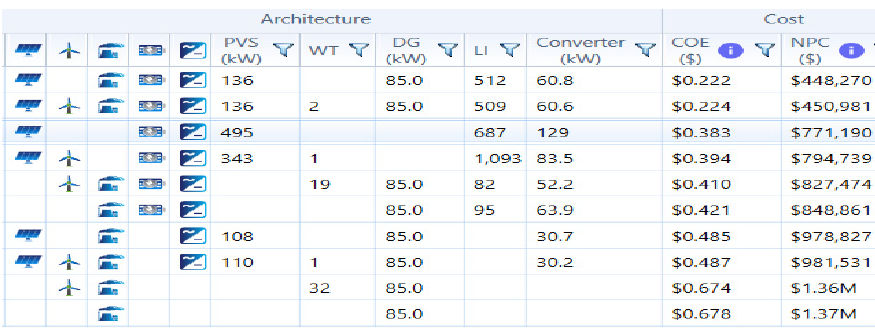
Figure 8. Optimization results from HOMER for solar, wind and generator with TSVA.